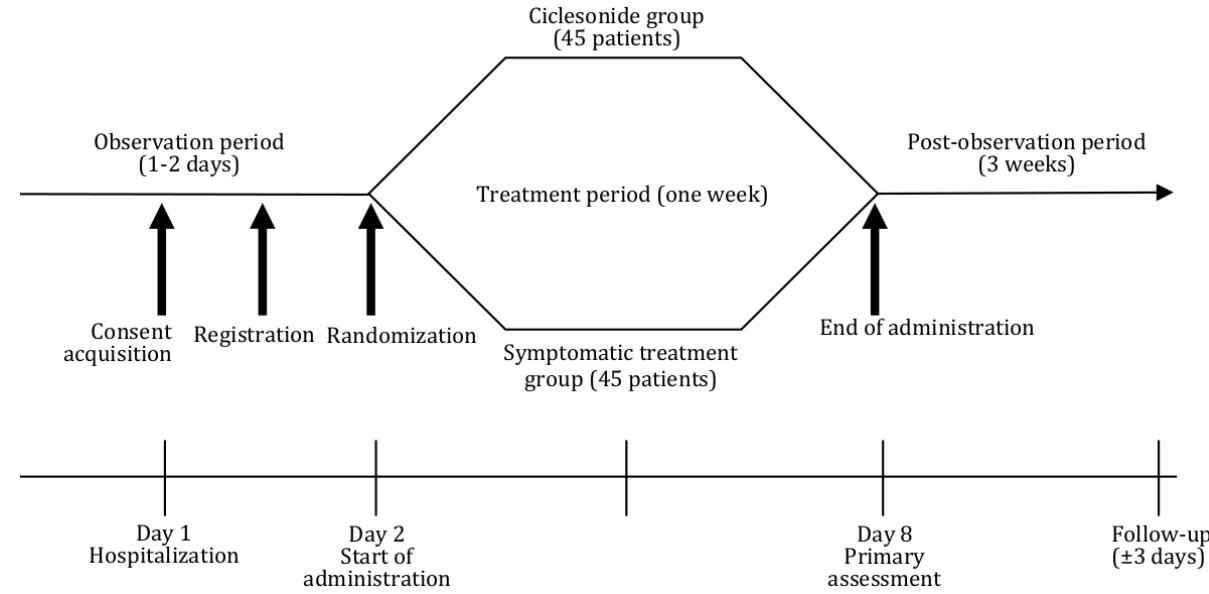
Figure 1. Trial design and